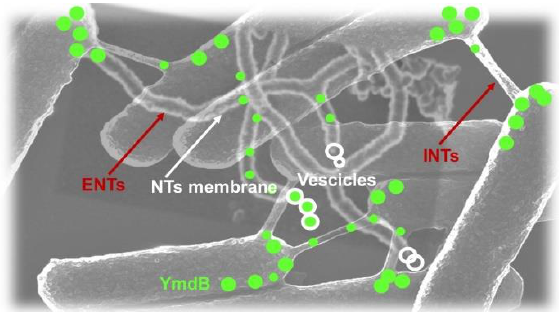
Figure 10. Example of a network of intercellular and elongated extending